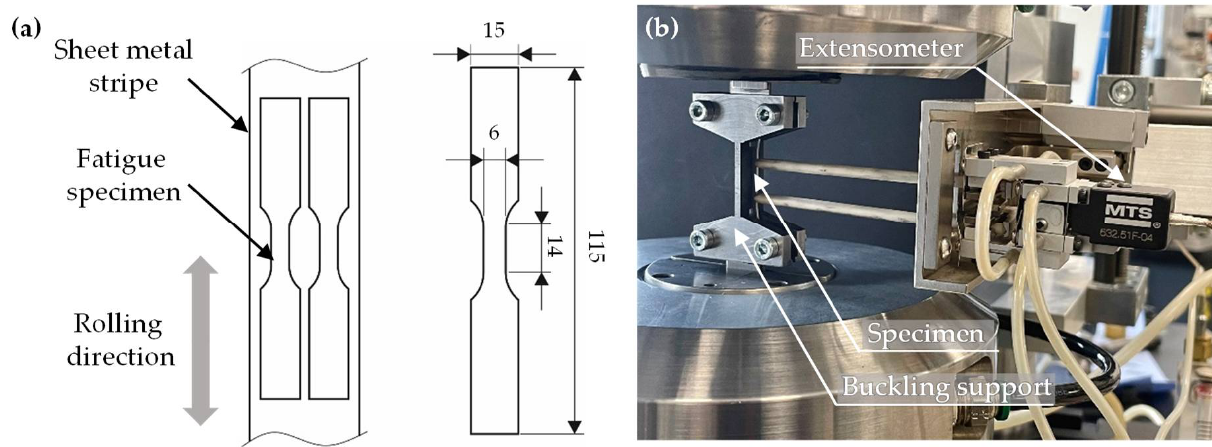
Figure 11. ( a ) Specimen geometry and orientation, ( b ) test setup of the strain-controlled fatigue experiments.